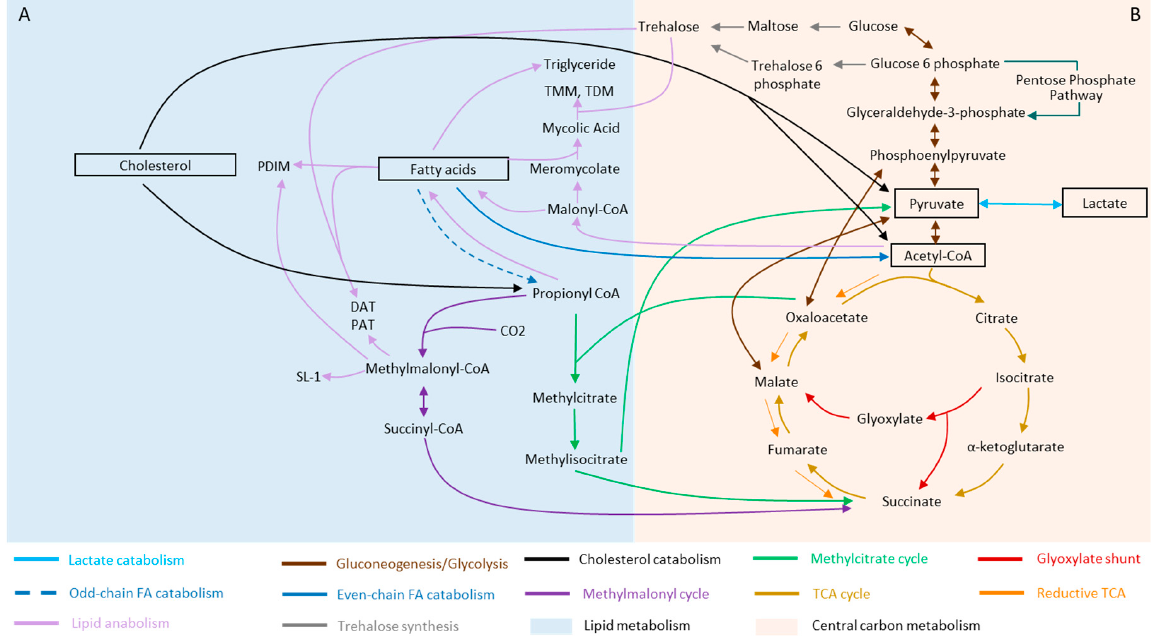
Figure 1. Schematic diagram linking central carbon metabolism (CCM) and lipid metabolism in Mycobacterium tuberculosis ( Mtb ). ( A ) Catabolism of cholesterol and fatty acids (dark blue and black arrows) produces a variety of substrates, including succinyl-coenzyme A (CoA), propionyl-CoA and acetyl-CoA, which are channeled into CCM. While acetyl-CoA enters the tricarboxylic acid cycle (TCA) cycle (gold arrows), succinyl-CoA and propionyl-CoA enter the methylmalonyl cycle (dark purple arrows) and methylcitrate cycle (green arrows), respectively. Dashed (- -) dark blue arrow indicates catabolism of odd-chain fatty acids while solid dark blue arrow indicates catabolism of even-chain fatty acids. Fatty acids further serve as building blocks for other lipids, including triglycerides, which are involved in dormancy, while methylmalonyl-CoA serves as precursors of more complex Mtb lipids, including sulfolipids, acylated trehalose (light purple arrows). ( B ) Mtb is able to adapt to varying conditions through the diversity of its central carbon metabolism pathways, including the pentose phosphate pathway (dark green arrow), and variations in the TCA cycle. When under favorable conditions, carbon will flow through the classic TCA cycle (gold arrows), favoring the biosynthesis of precursors and generation of adenosine triphosphate (ATP). During infection when the bacterium is exposed to various stress conditions, carbon intermediates can also go through the reductive branch of the TCA cycle (orange arrows) or glyoxylate shunt (red arrows) in Mtb . These pathways are important for the regeneration of metabolites such as succinate, which is essential for instance in adaptation to hypoxia. During growth, intermediates of the TCA cycle must be withdrawn for the biosynthesis of fatty acids, nucleotide bases and amino acids through gluconeogenesis. These intermediates are replenished to achieve steady levels for normal TCA function by anaplerosis. The anaplerotic node is the metabolic link between glycolysis, gluconeogenesis (dark red arrows) and the TCA cycle (gold arrows) and acts as a switch that directs the flow of carbon distribution within the CCM. An example of anaplerosis is during growth on fatty acids, when the glyoxylate shunt (red arrows) serves to replenish malate via isocitrate lyase and malate synthase. Glucose further serves as a precursor for trehalose (grey arrow), which is a building block of glycolipids. Abbreviations: SL-1 = sulfolipid-1; FA = fatty acid; TCA = tricarboxylic acid cycle, CoA = coenzyme A; CO 2 = carbon dioxide; DAT = diacyl trehalose; PAT = poly-acyl trehalose; PDIM = phthiocerol dimycocerosate; TMM = trehalose monomycolate; TDM = trehalose dimycolate. Note: the schematic is a simplified form and do not represent all steps of the biosynthesis and catabolic pathways of the various